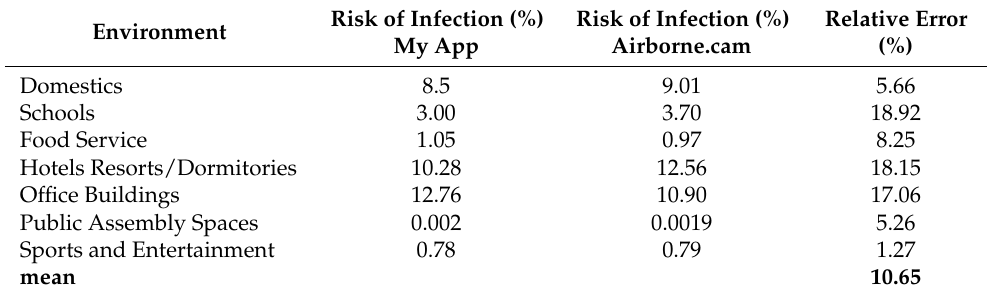
Table 13. Comparison results with reference [19].